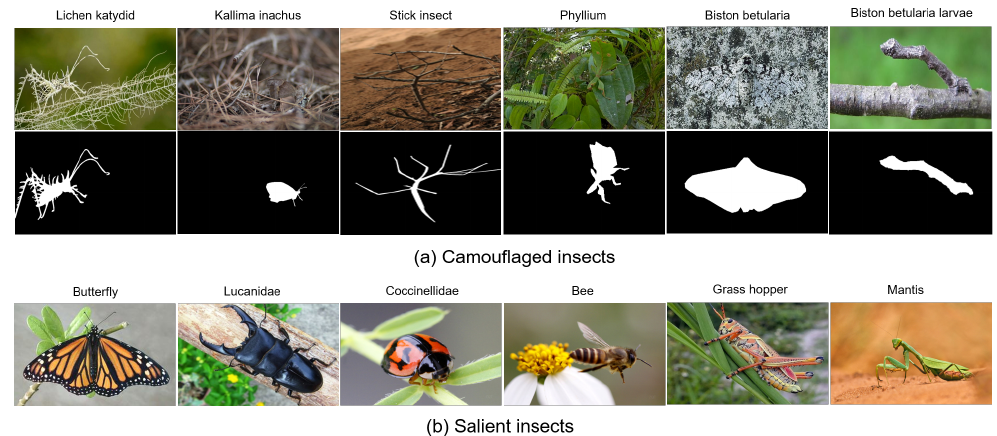
Figure 1. Examples of salient and camouflaged